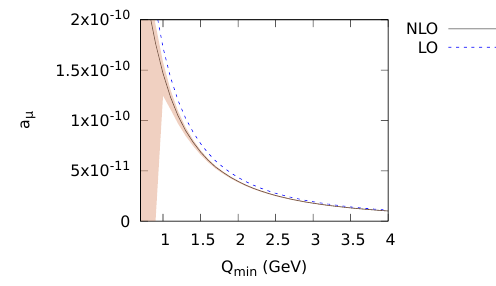
Figure 6. Two-loop gluonic corrections to the per- turbative quark loop.